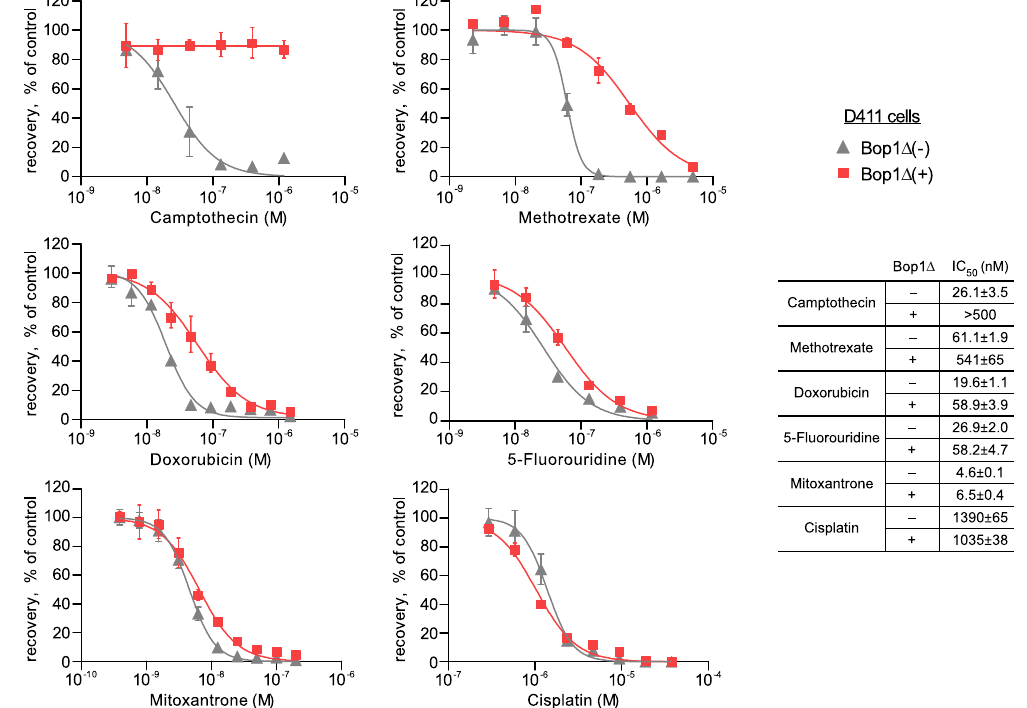
Figure 2. Bop1 Δ expression increases cell survival in treatments with chemotherapeutic drugs. Bop1 Δ was induced for 24 h with IPTG or not induced, and cells were treated with various concentrations of the indicated drugs for 24 h, except MTX treatment, which was 48 h. After recovery for 120 h in drug-free medium, viable cells were quantified using alamarBlue assays as detailed in Methods. Data in each graph are normalized to the no-treatment control and show mean and s.d. values in triplicate samples; where error bars are not visible, they are smaller than the symbol size. The tabulated IC 50 values are presented as mean ±